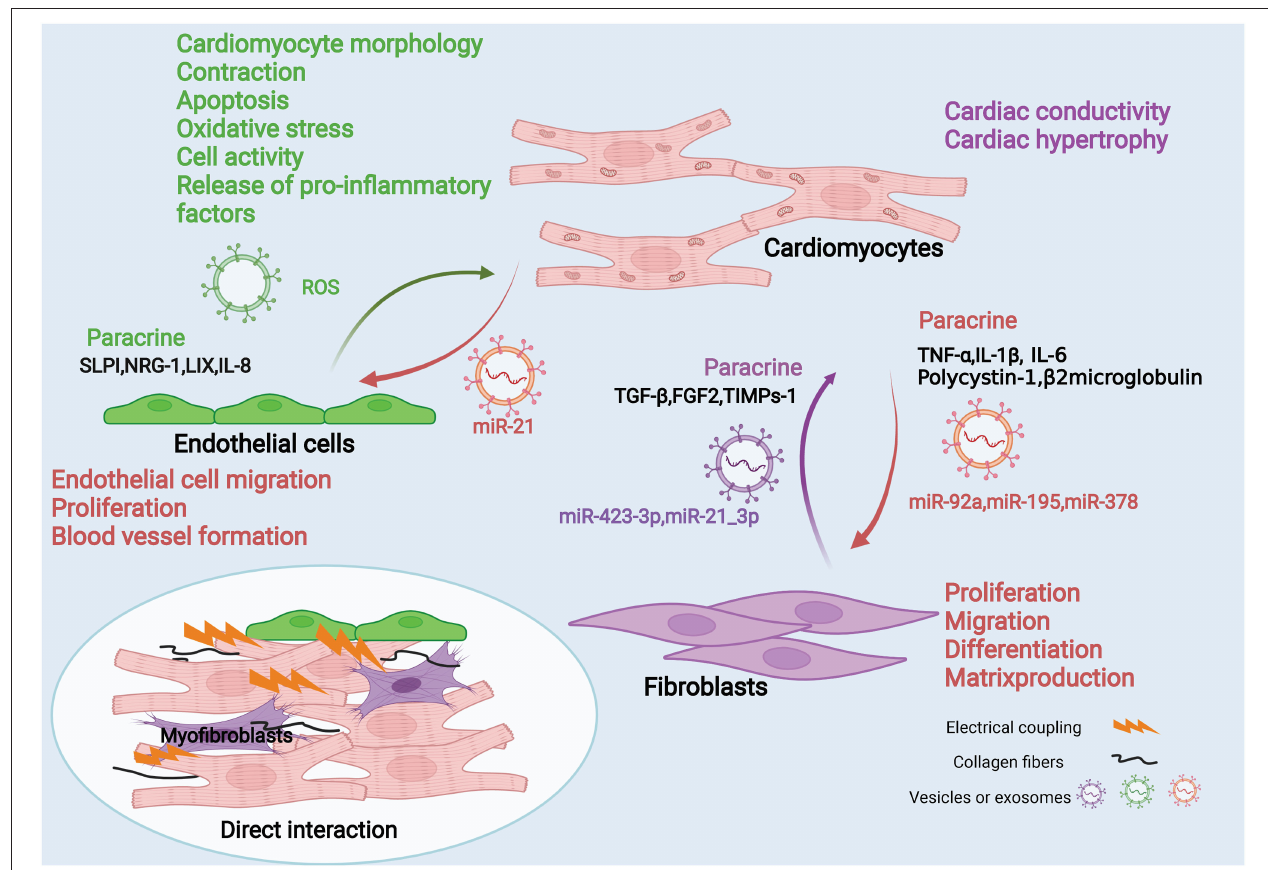
FIGURE 2 | Fibroblasts, endothelial cells and cardiomyocytes interaction diagram. Fibroblasts, endothelial cells can interact with cardiomyocytes through mechanical coupling and electrical coupling. They also act through paracrine effects and/or cell-secreted vesicles or exosomes. Cardiomyocytes secrete pro-inflammatory factors such as TNF- α , IL-1 β , and IL-6 through paracrine effects to act on fibroblasts, and they can also deliver intracellular miRNAs through exosomes, such as miR92a, miR195, and miR378. These mediators can affect fibroblast proliferation, migration, differentiation and matrix production. Fibroblasts can also secrete factors such as TGF- β through paracrine action or deliver miRNAs into cardiomyocytes through exosomes, which affect cardiomyocyte contraction and cardiac hypertrophy. Similarly, endothelial cells can secrete effector molecules such as IL-8 through paracrine effects, and can also carry ROS through exosomes, thereby affecting various functions of cardiomyocytes. In contrast, cardiomyocytes can affect endothelial cell migration, proliferation, and angiogenesis by secreting exosomes carrying molecules such as